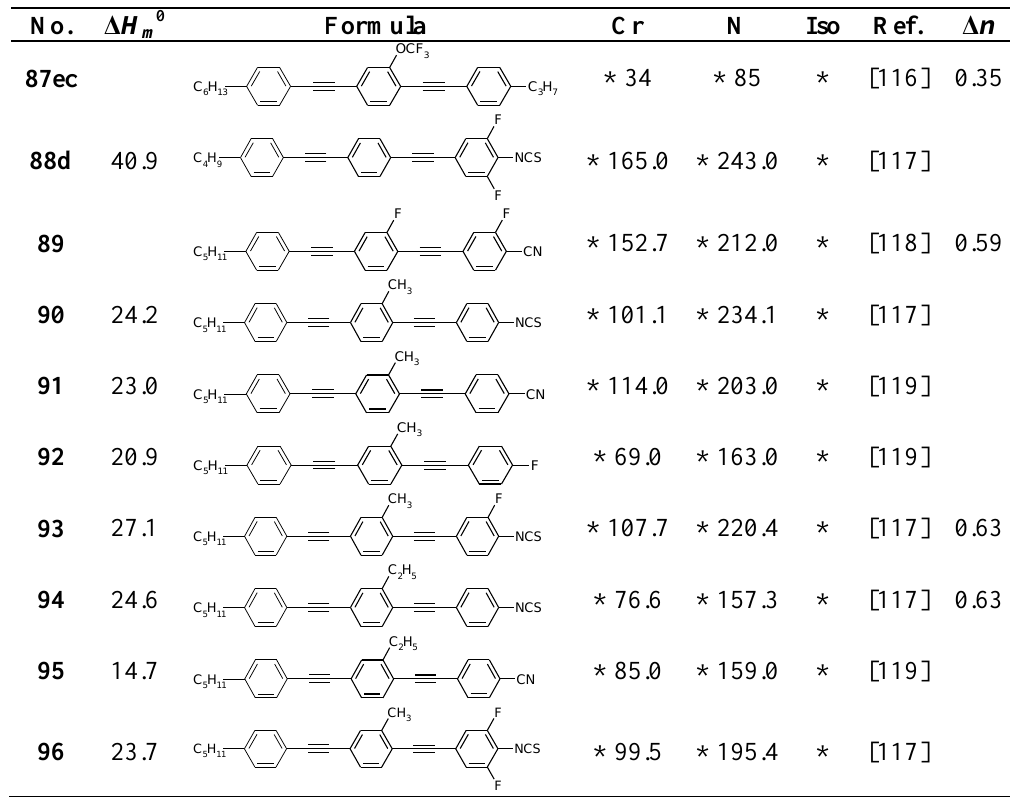
Table 13. Phase transition temperatures [°C], melting enthalpies [kJ/mol] and birefringence of three-ring